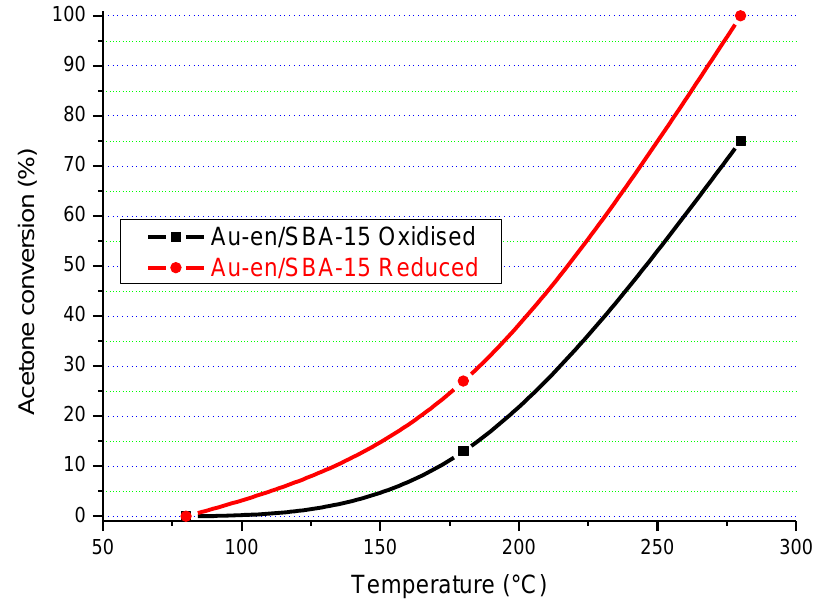
Figure 16. Complete oxidation of acetone over oxidised and reduced Au-en/SBA-15 samples.